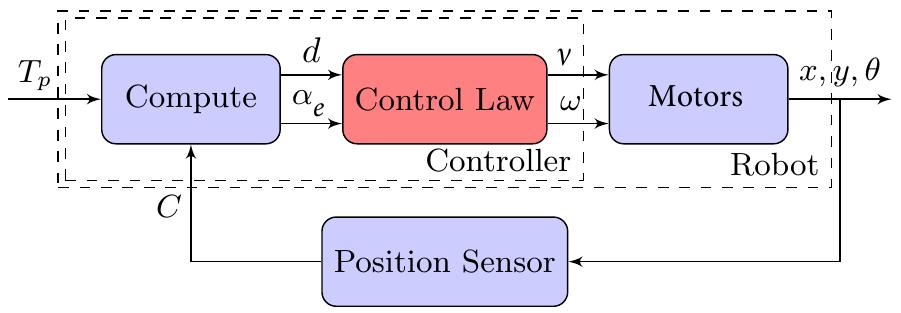
Figure 8. Position control block